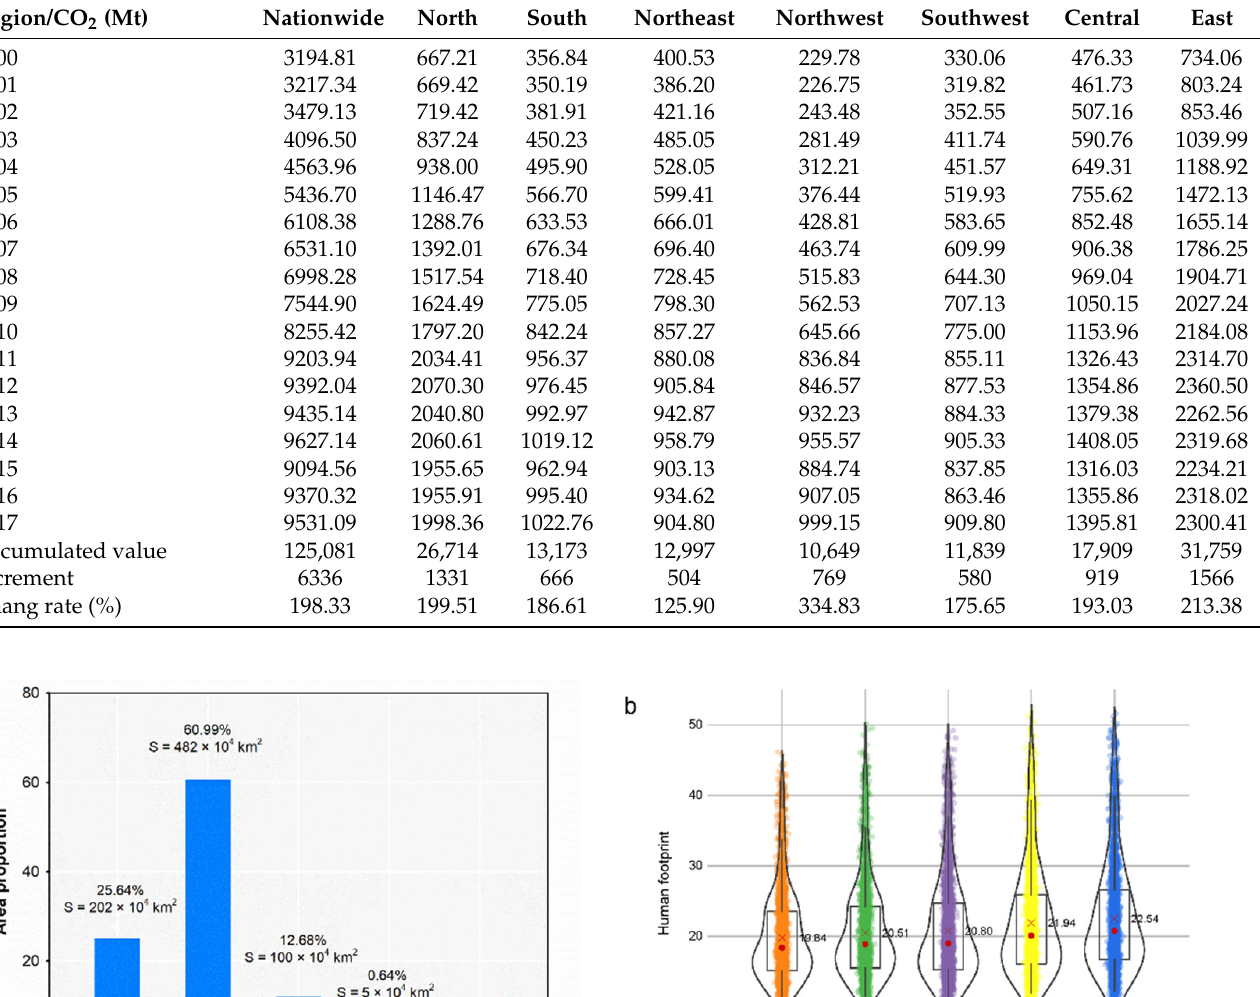
Table 2. Average CO 2 emissions in different regions of China during 2000–2017.